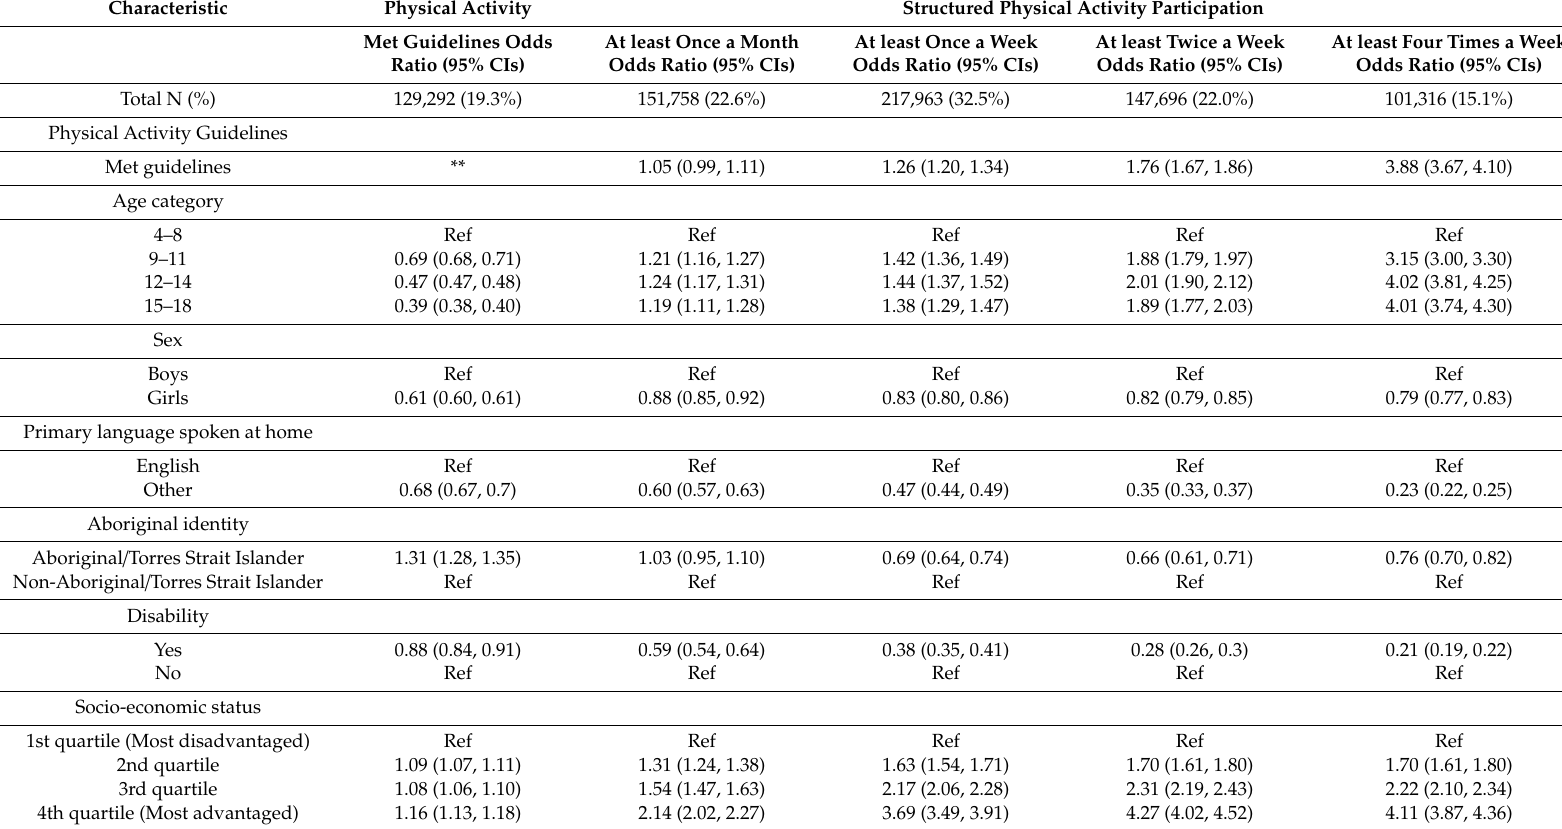
Table 2. Odds ratios of children at registration meeting physical activity guidelines and participating in structured physical